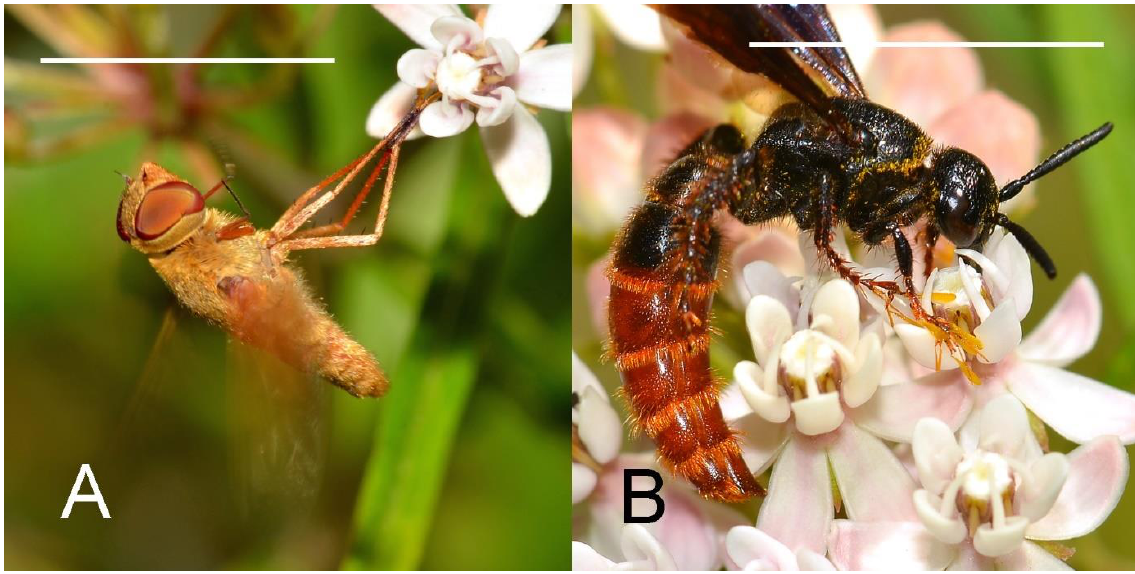
F IGURE 2. (A)Live Chrysanthrax editulus (Bombyliidae), trapped in flower, 5 June 2019 (SAP). (B) Scolia dubia (Scoliidae), with pollinia, 30 August 2018 (ASH). Scale bars = 10